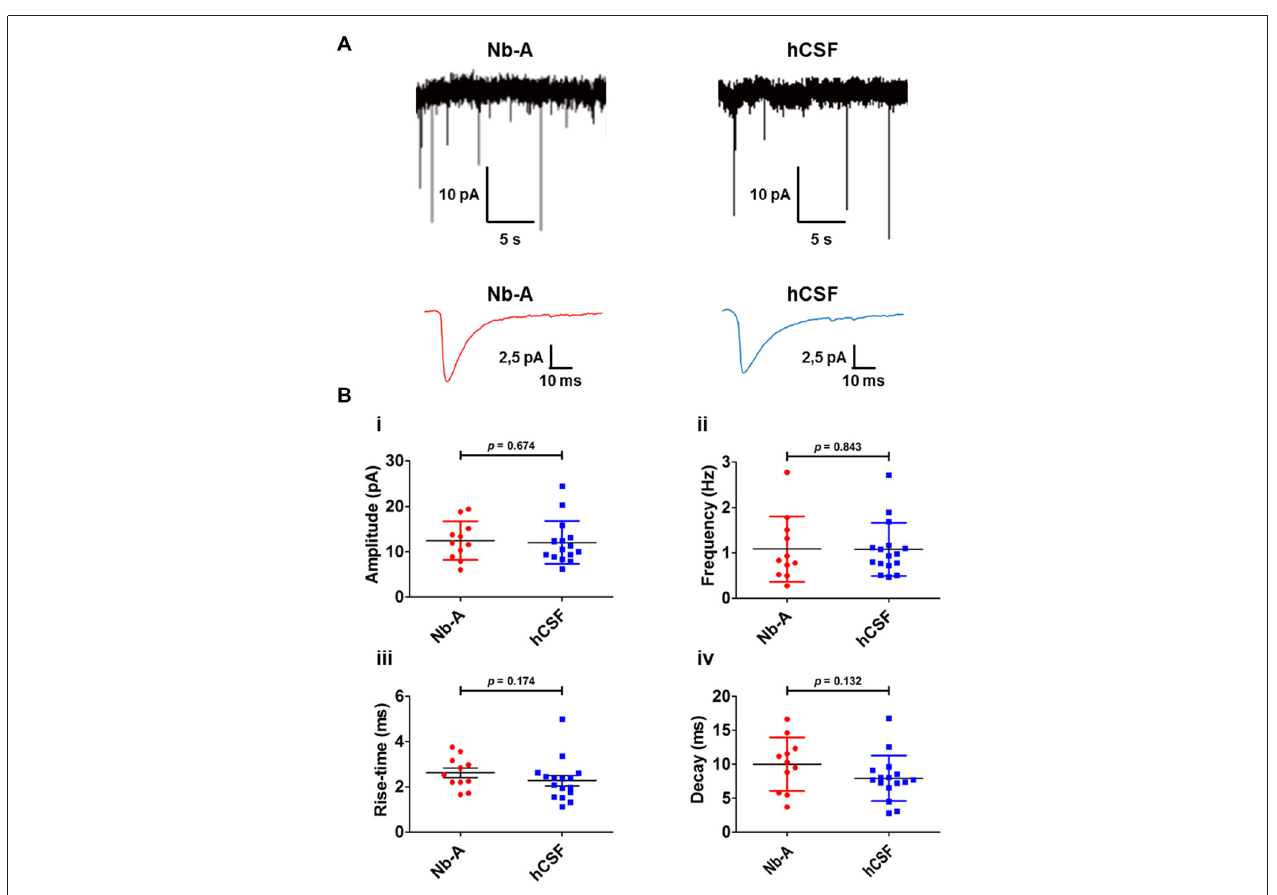
FIGURE 6 | Miniature AMPA receptor-mediated transmission (AMPA mEPSCs) in organotypic hippocampal slices cultured in Nb-A and in hCSF. (A) Example recordings of miniature AMPA receptor-mediated EPSCs in CA1 pyramidal cells from organotypic hippocampal slices cultured in Nb-A (left) or in hCSF (right). Corresponding average AMPA mEPSCs are shown below. (B) Diagrams showing amplitude (i) , frequency (ii) , rise-time (iii) and decay (iv) of AMPA mEPSCs recorded in organotypic hippocampal slices cultured in Nb-A ( N = 11) or in hCSF ( N = 16; mean ±